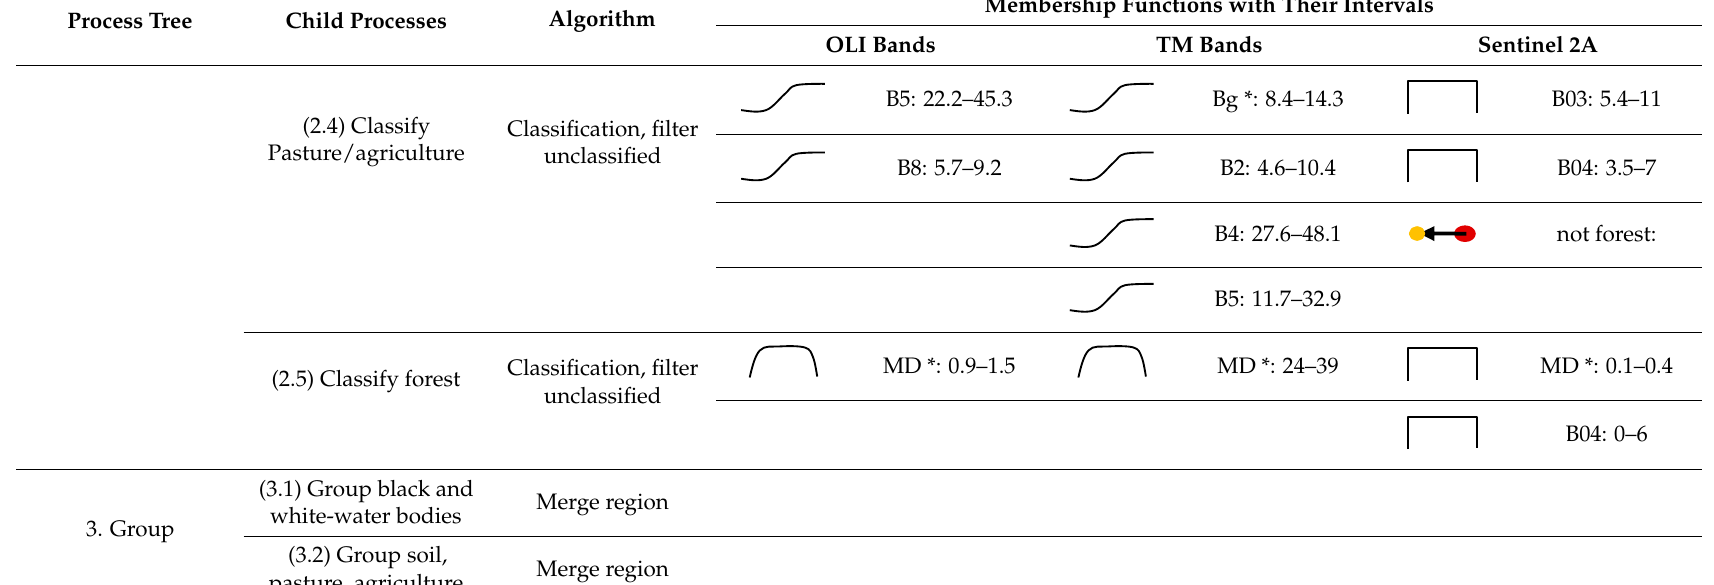
Table 1. The process tree, child processes, algorithms, and membership functions used in the LCLU classification following the GEOBIA approach. Process Tree